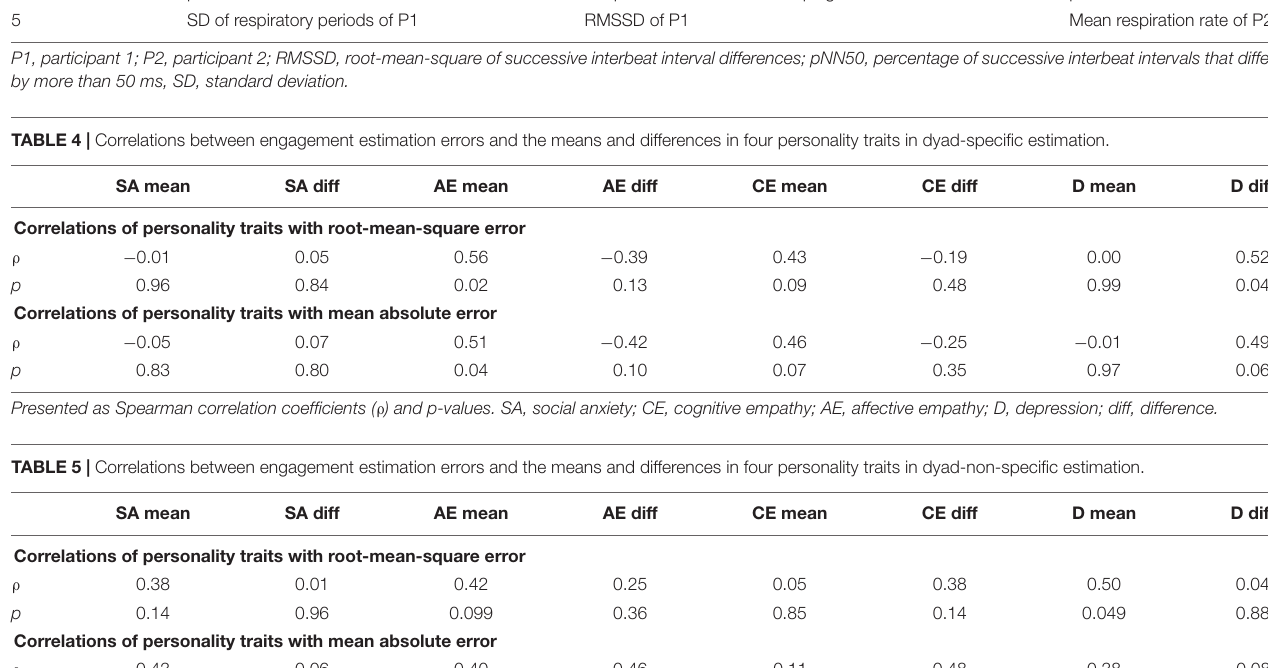
Correlations of personality traits with root-mean-square error